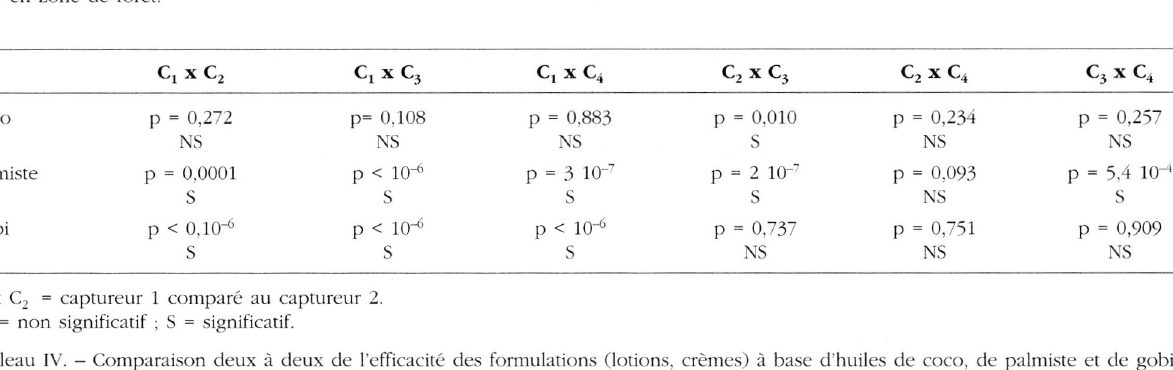
Tableau IV. - Comparaison deux à deux de l'efficacité des formulations (lotions, crèmes) à base d'huiles de coco, de palmiste et de gobi selon le captureur en zone de forêt.